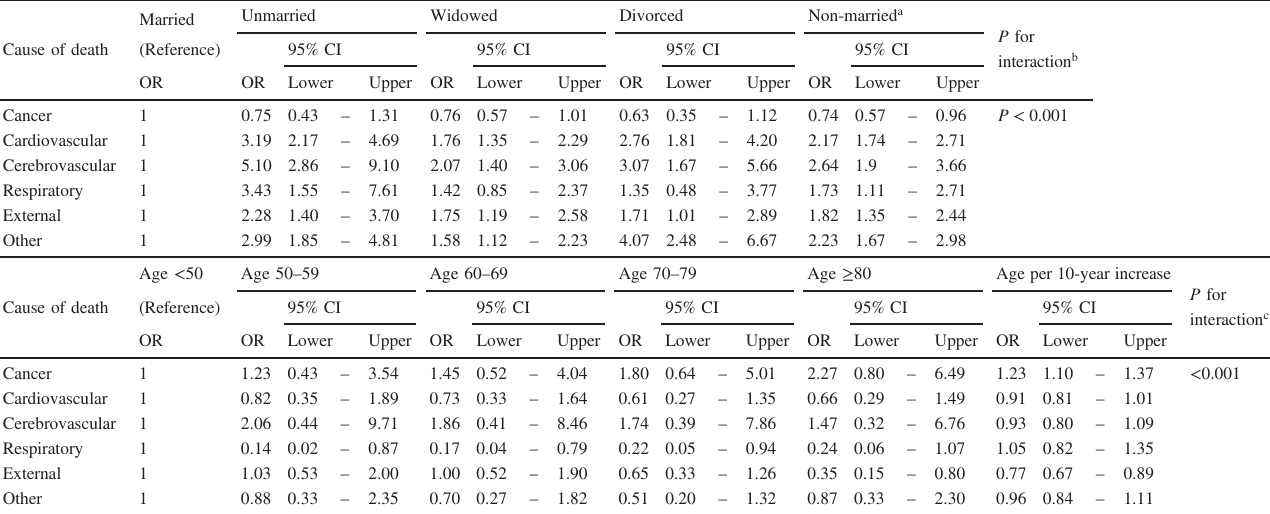
Table 3. Odds of home death according to marital status by cause of death